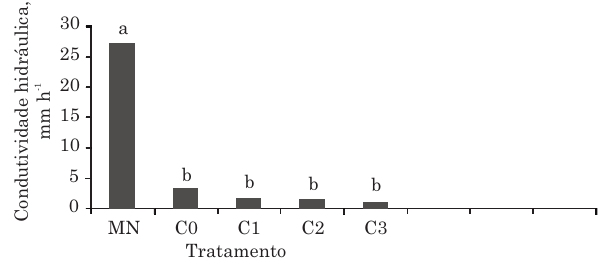
Figura 1. Condutividade hidráulica de um Latossolo Vermelho eutroférrico submetida a quatro tratamentos e a Mata Nativa até 0,10 m de profundidade. Médias seguidas da mesma letra não diferem estatisticamente pelo teste de Tukey (p<0,05) (CV = 64,25